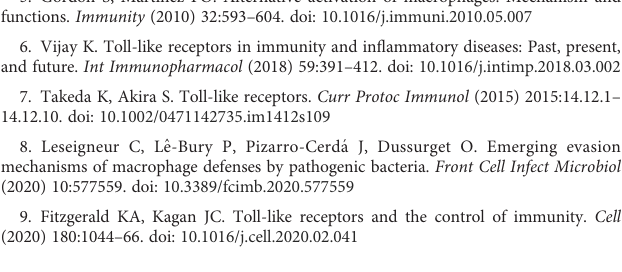
SUPPLEMENTARY FIGURE 1 (A) Graphical representation of gene expression of Cav-1 after transfection of different concentrations (5,10, 25, and 50 µM) of cav-1 siRNA to THP-1 cells. (B) Immunoblotting image of transfection of different concentrations (5,10, 25, and 50 µM) of cav-1 siRNA. (C) Bar Graph of Mean fl uorescence intensity of the variousTLRs(Redbars)andCav-1(greenbars). (D) Aminoacidresiduesandtheir interaction between Cav-1 (purple) and TLR4 (Red). (E) Representative images of cell migration assay under various conditions under a light microscope. Results were expressed as mean ± SD. Statistical Analysis was performed non- parametrically using the One-way Analysis of variance (ANOVA) with Tukey ’ s multiple comparison tests to determine signi fi cant differences between the experimental groups. *p<0.05, **p<0.01 and ***p<0.005 set as Statistical signi fi